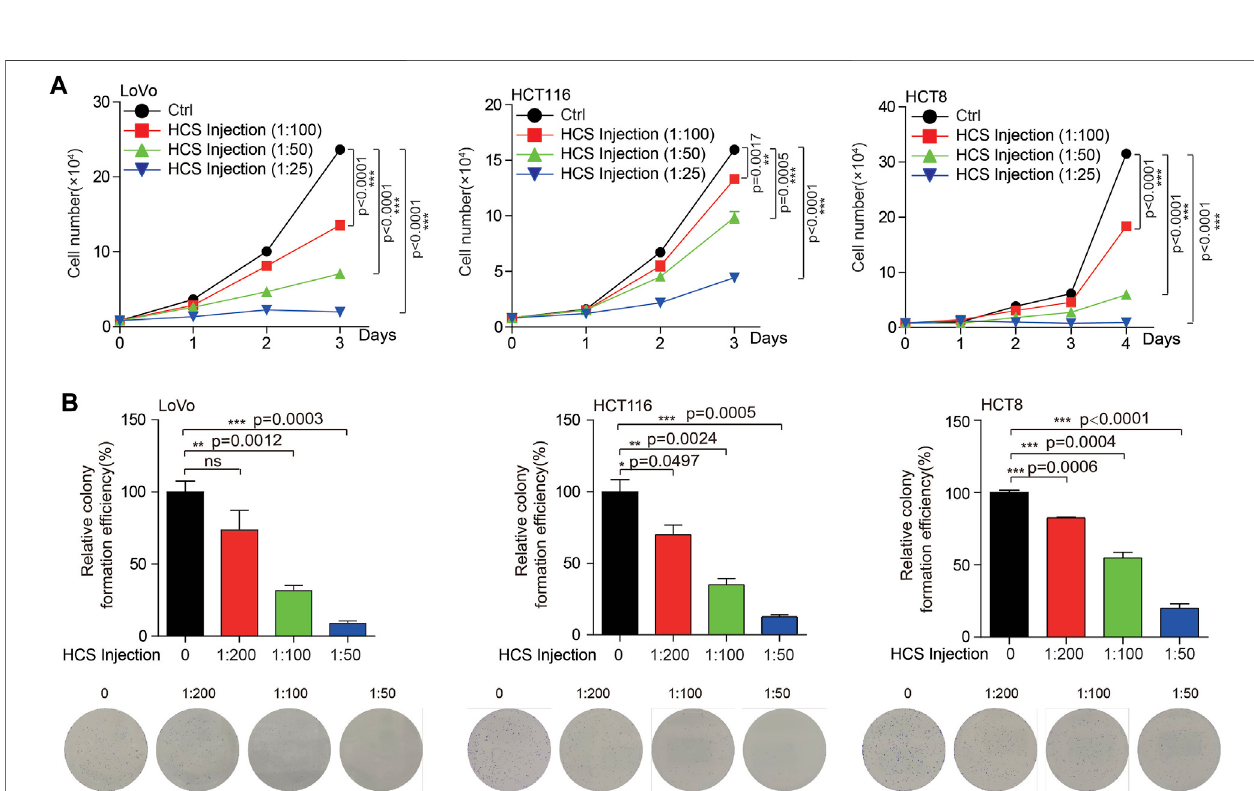
FIGURE2| Cinobufotalin inhibitsthegrowthofcoloncancercells (A) Cellgrowthwasdeterminedbycellcountingincoloncancercells(LoVo, HCT116and HCT8) treated with gradient concentration of cinobufotalin (B) Cell proliferation was determined by colony formation in colon cancer cells (LoVo, HCT116 and HCT8) treated withgradient concentration ofcinobufotalin. Error bars represent mean values ±SD from three replicates ofeach sample (ns: p > 0.05; *: 0.01 < p < 0.05; **: 0.001 < p < 0.01; ***: p < 0.001).